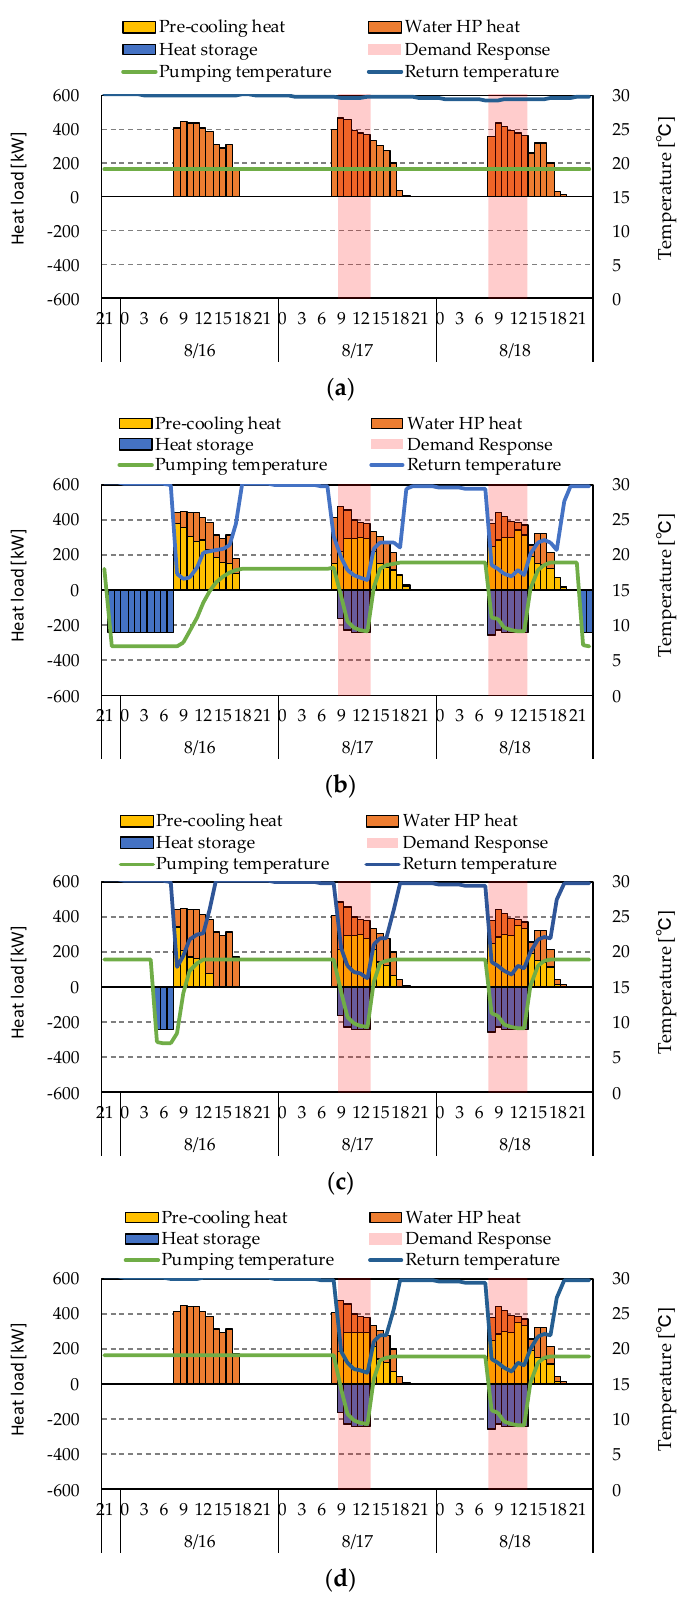
Figure 12. A comparison of operation transitions on the representative days of each case: ( a ) Water- cooled HP operation; ( b ) 10-h nighttime heat storage operation and DR heat storage operation; ( c ) 3-h night heat storage operation and DR heat storage operation; ( d ) DR heat storage